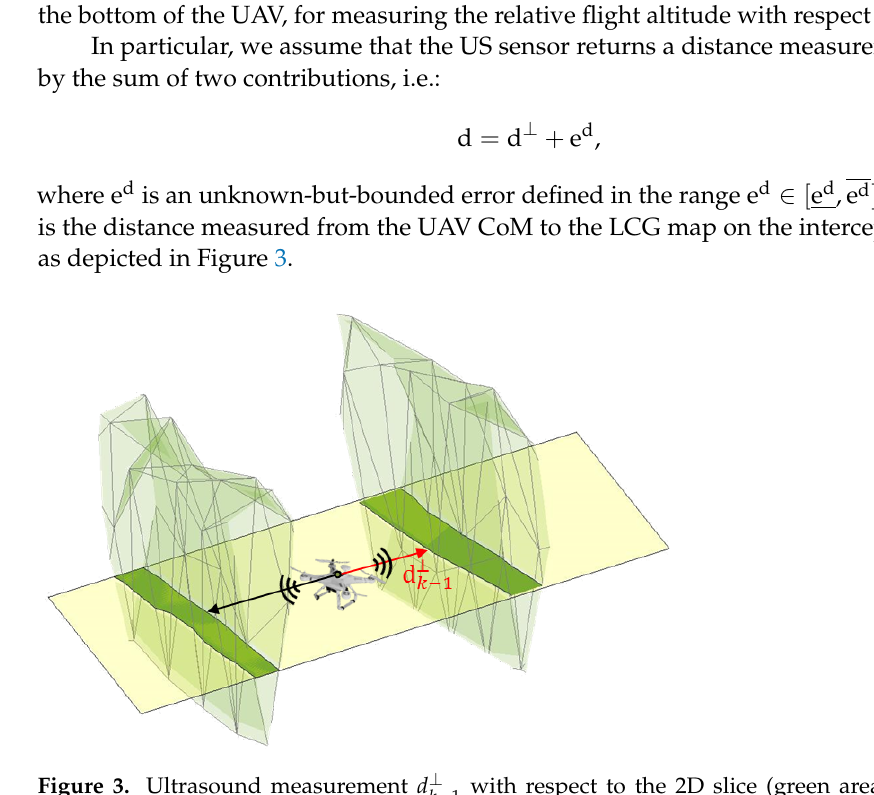
Figure 3. Ultrasound measurement d ⊥ with respect to the 2D slice (green area) obtained by k − 1 intersecting the 3D LCG map with the 2D (yellow) plane, passing throug the UAV